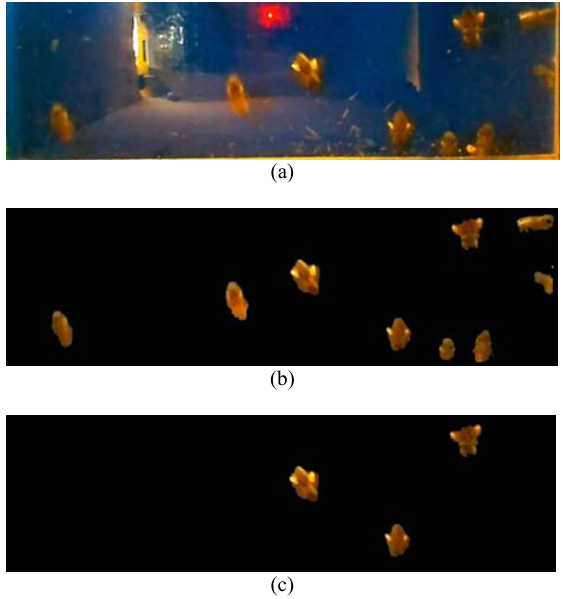
Figure 5. (a) An analyzed part of a recorded video frame, (b) segmented honey bees, (c) recognized pollen bearing honey bees (best viewed in color)